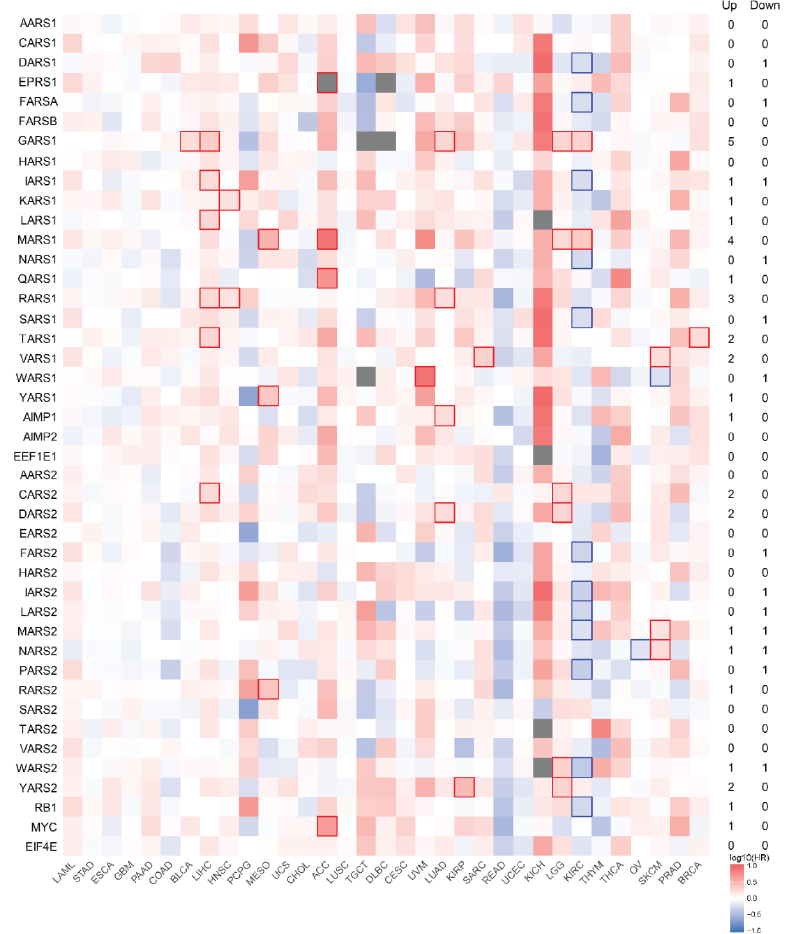
Figure 4. Survival map of Kaplan–Meier survival curves for aaRSs over TCGA cancer types. Kaplan–Meier curves were generated comparing survival between patients with high and low mRNA expression of each aaRS in the TCGA cancer types (median cuto ff ) and hazard ratios (HRs) were calculated comparing high expression to low expression groups. The significance of the di ff erence between groups was computed (log-rank test, FDR (false discovery rate) adjusted, q -value < 0.05) and boxes with a significant di ff erence are outlined in either red or blue depending on the direction of the HR. Boxes in gray exceed the limits of the scale and represent especially high or low HR values, although they may not be significant. The 33 cancer types are sorted based on overall survival data from the TCGA database, from shortest median time to event (death) (LAML) to the longest